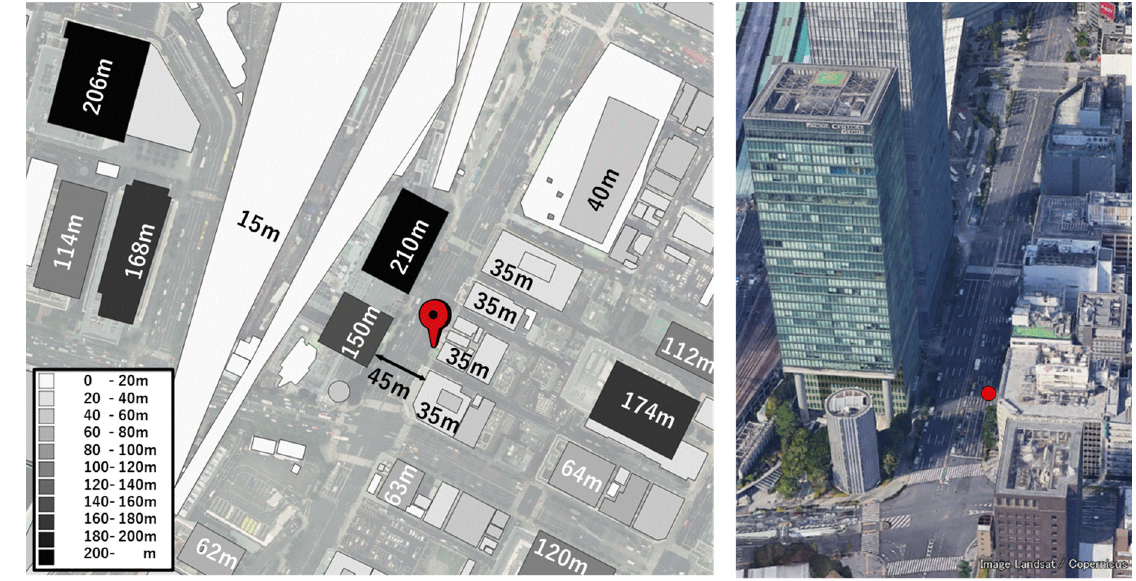
Figure 2. Target location for investigating carrier to noise ratio (C / N 0 ) in dense urban Figure 2 . Target location for investigating carrier to noise ratio (C/N 0 ) in dense urban areas.